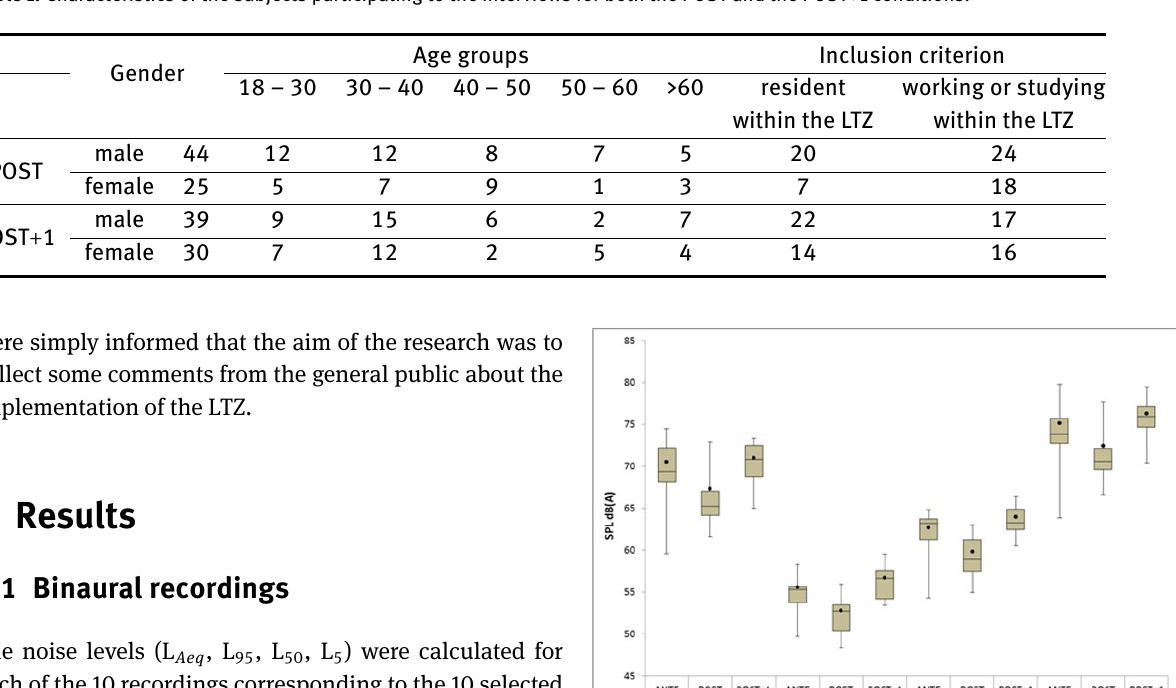
Table 1: Characteristics of the subjects participating to the interviews for both the POST and the POST + 1 conditions.